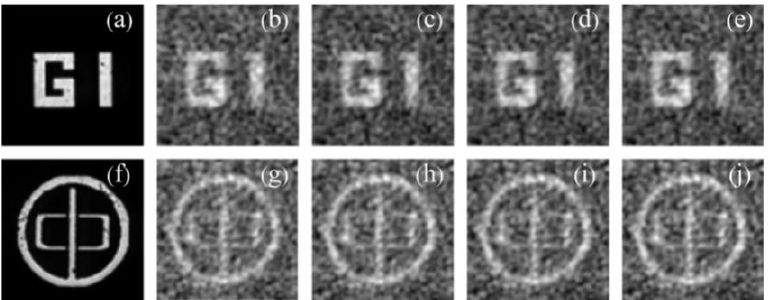
Figure 3. Experimental results for the “GI” and “ZHONG” obtained by the GI with 2000, 3000, 4000, and 5000 groups of data. ( a , f ) original image with 80 × 80 pixels; ( b , g ) the reconstructions with 2000 groups of data;( c , h ) the reconstructions with 3000 groups of data; ( d , i ) the reconstructions with 4000 groups of data; ( e , j ) the reconstructions with 5000 groups of data.